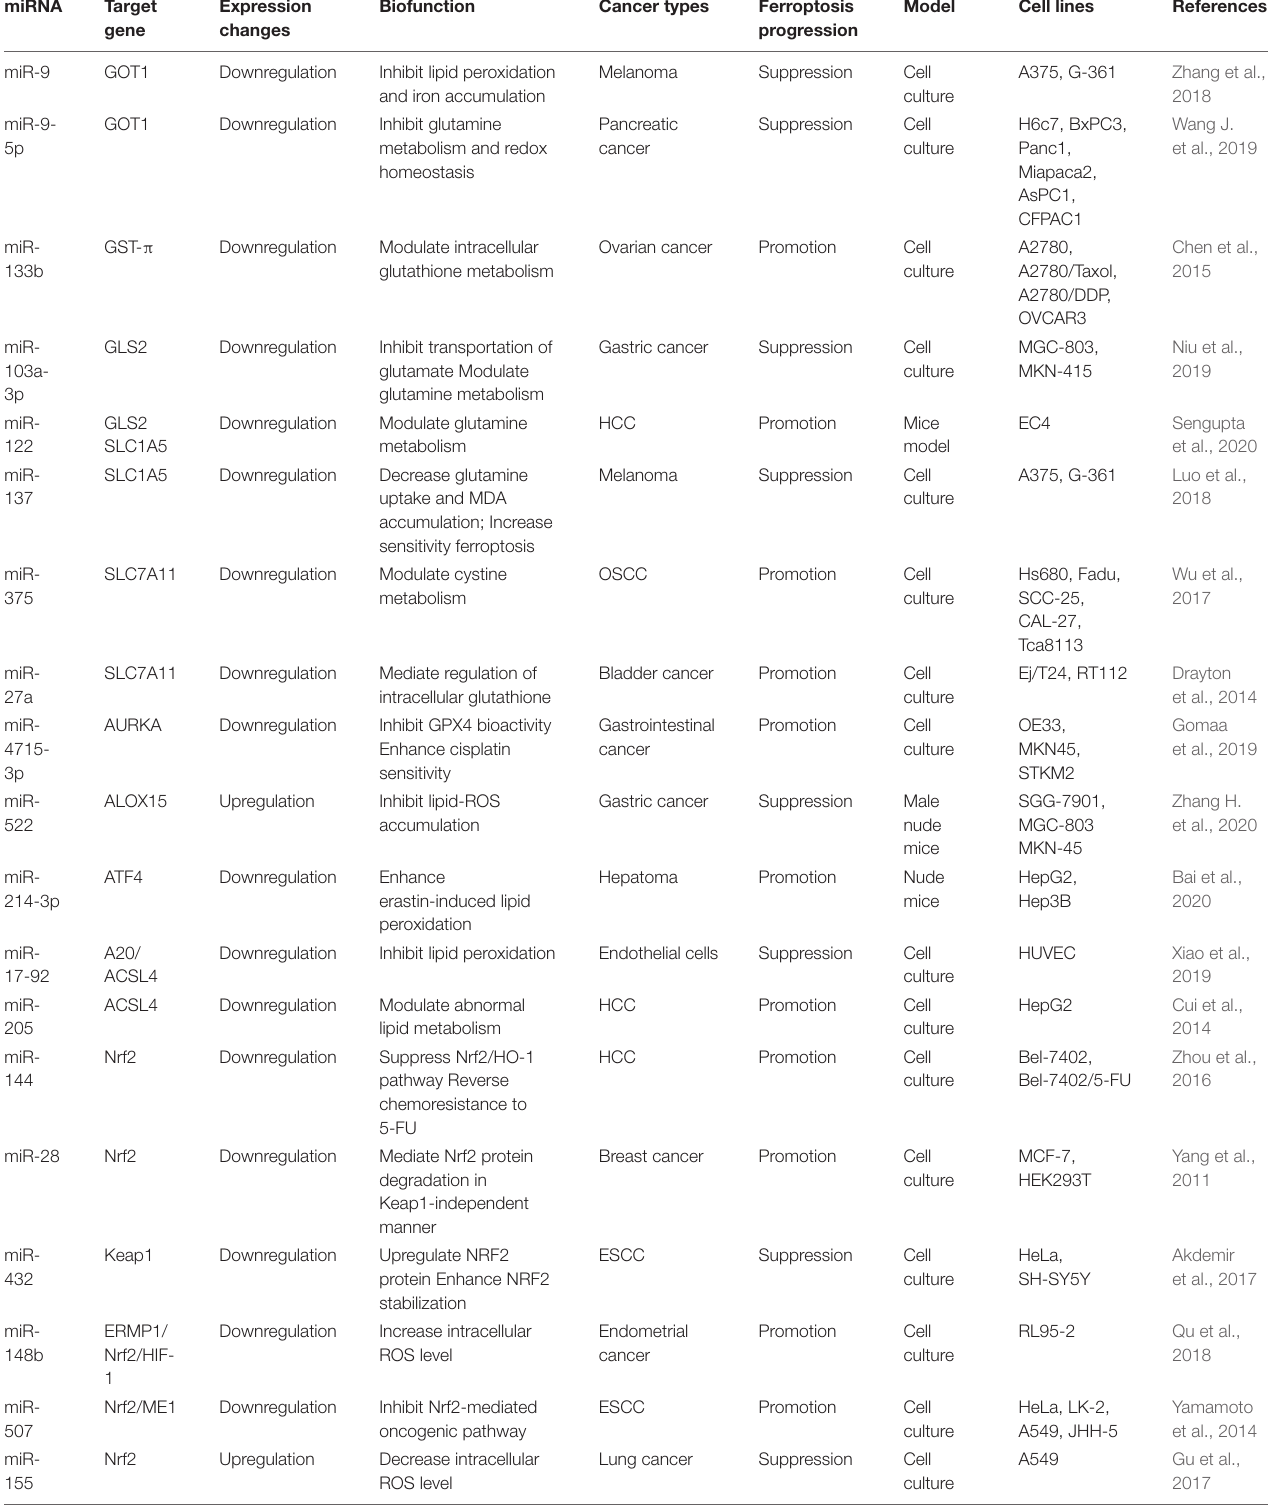
TABLE 1 | Biofunction of miRNAs in regulating ferroptosis in cancer cells.